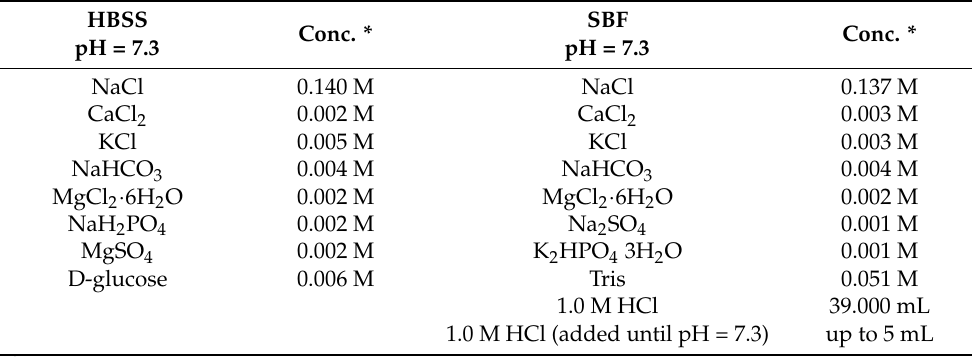
Table 1. Chemical composition of solutions prepared for bioactivity